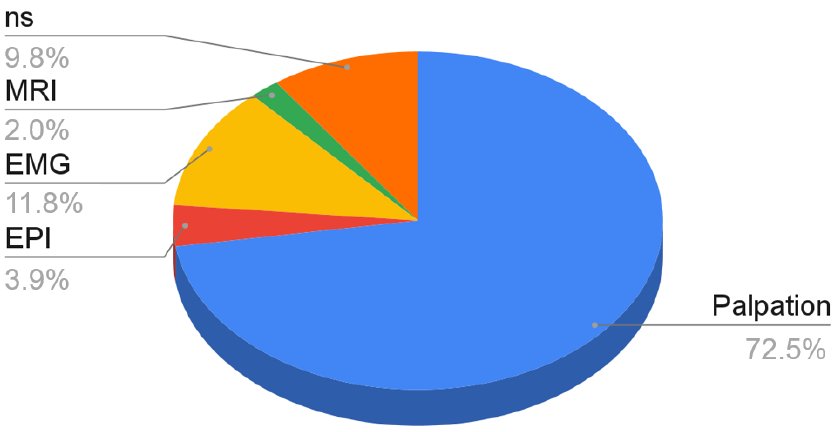
Figure 4. Navigational methods in needling of the masticatory muscles in relation to the number of analyzed studies.